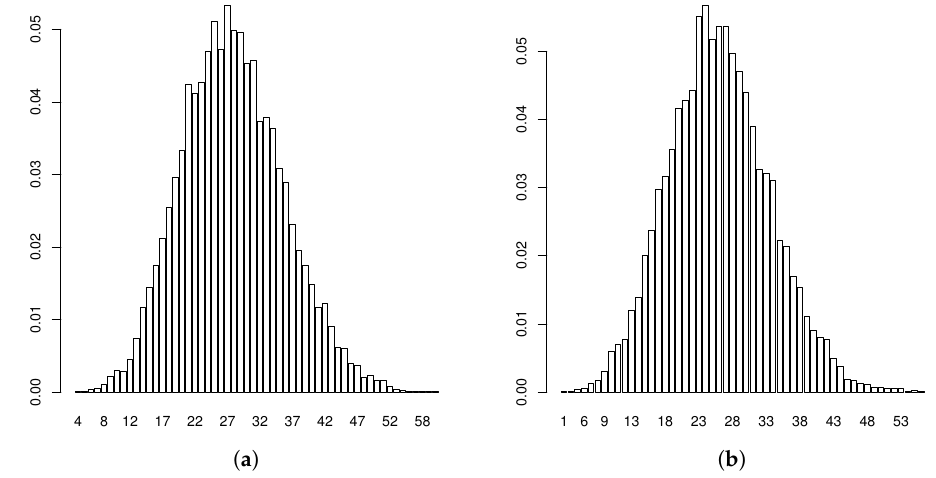
Figure 5. Estimated predictive distributions of Mr 5 |FM 4 ( a ) and MR 5 |FM 4 ( b